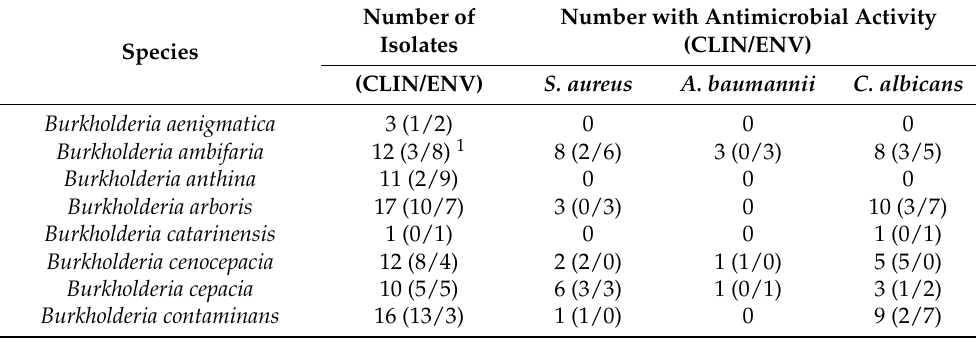
Table 1. Collection of Burkholderia isolates screened for antimicrobial activity. Isolates were screened for antimicrobial activity against Staphylococcus aureus ATCC 29213, Acinetobacter baumannii LMG 10520, and Candida albicans SC5314 using an overlay assay. Antimicrobial activity was defined as an inhibition zone diameter ≥ 5 mm. Isolates were assigned to Other Bcc groups by means of multilocus sequence typing analysis as described previously [31]. CLIN, clinical; ENV,